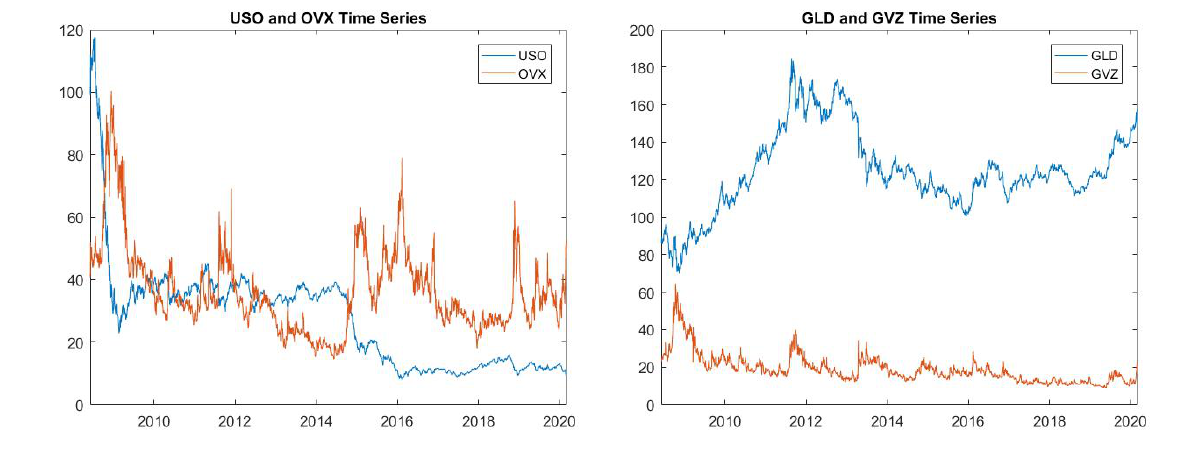
Figure 2. Historical USO (OVX) and GLD (GVZ)